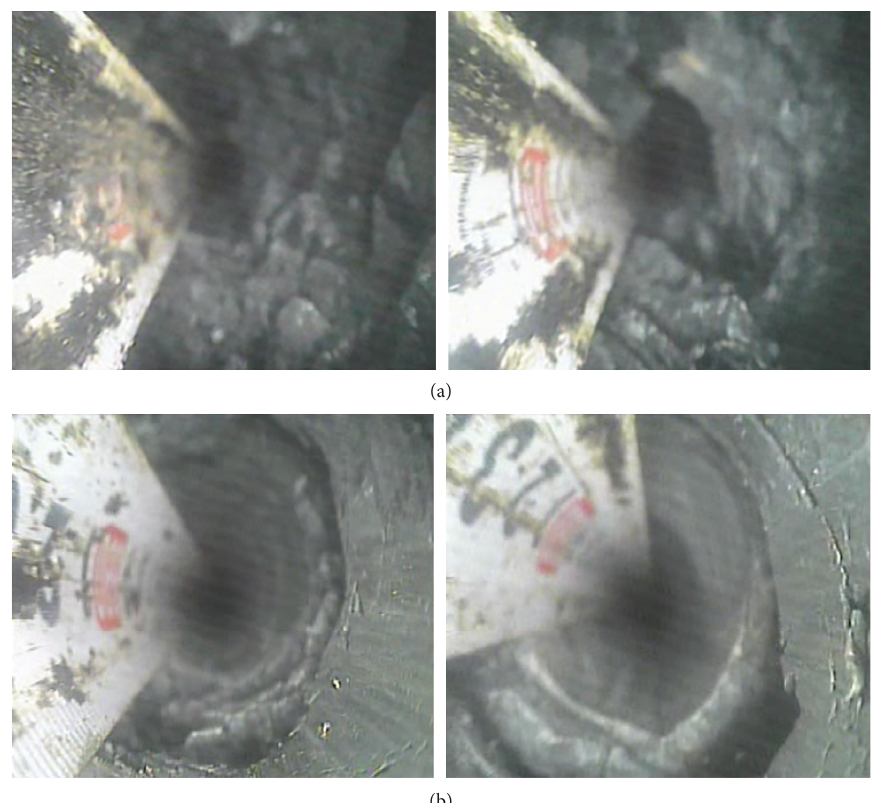
Figure 10: Two sides of water pump house surrounding rock peeping results (one hole in each of one side). (a) Broken rock mass. (b) More complete rock